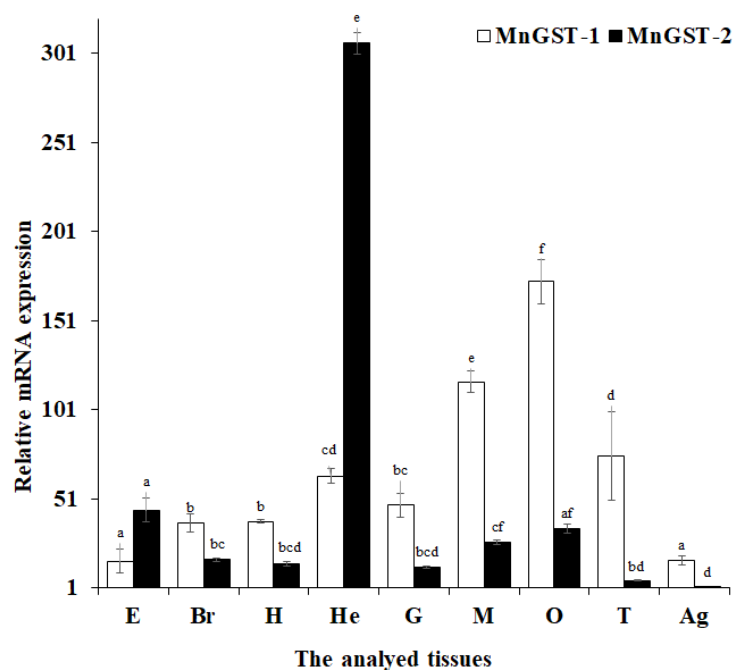
Figure 2. Expression of MnGST-1 and MnGST-2 in different tissues (E: eye; Br: brain; H: heart; He: hepatopancreas; G: gill; M: muscle; O: ovary; T: testis; Ag: abdominal ganglion) of Macrobrachium nipponense. Bar charts with different lowercase letters show significant differences in MnGST-1 and MnGST-2 ( p < 0.05). Values are means ± standard error of the mean (SE) for triplicate samples.